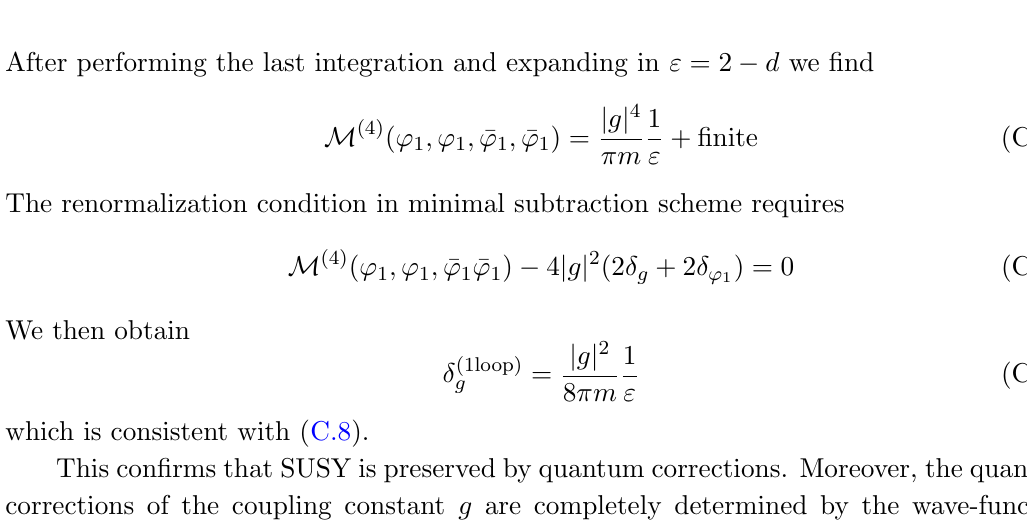
Figure 19. One-loop 1PI correction to the four-point vertex with external scalars from sector 1, coming from the s